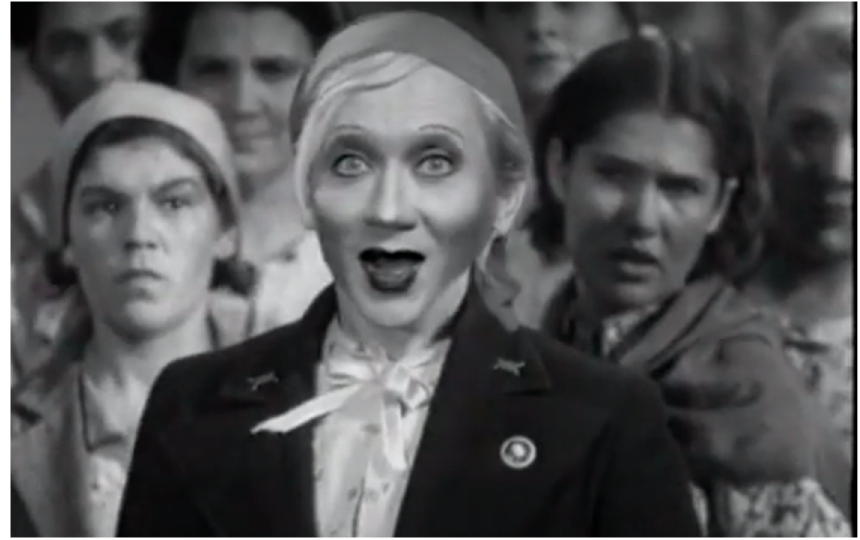
Figure 15. Vlad Mamyshev-Monroe as Strelka in Volga-Volga (2006, a remake of the 1937 film dir. by Pavel Labazov and Andrei Sil’vestrov).